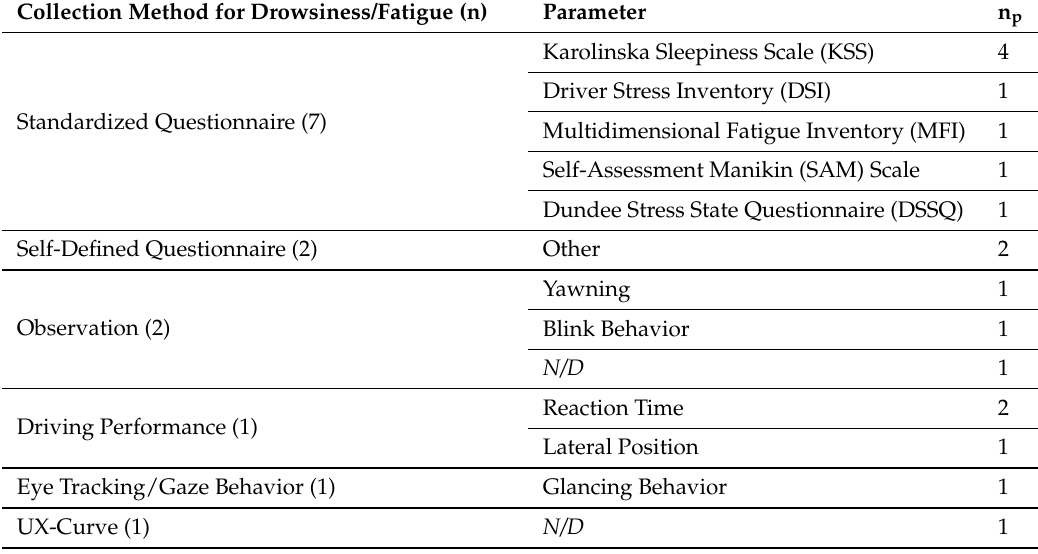
Table 10. Drowsiness/Fatigue collection methods and